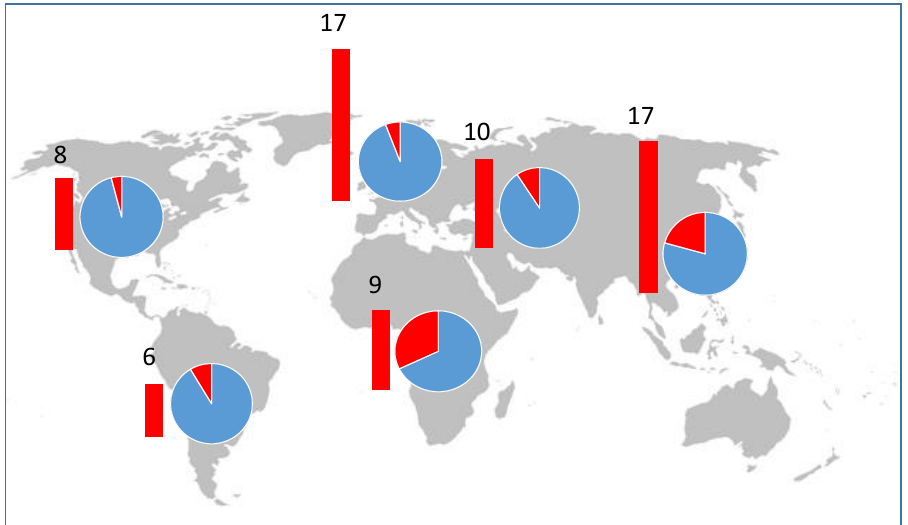
Figure 4. Exports of infected seed lots from major seed production regions. Numbers of infected seed lots (red bars) and the proportions of infected seed lots (pie charts), as calculated from the number of infected lots and the total known number of lots tested. Countries were identified from certification documentation that arrived with the seed lots. Seed lots were only included in this dataset when the production country data was